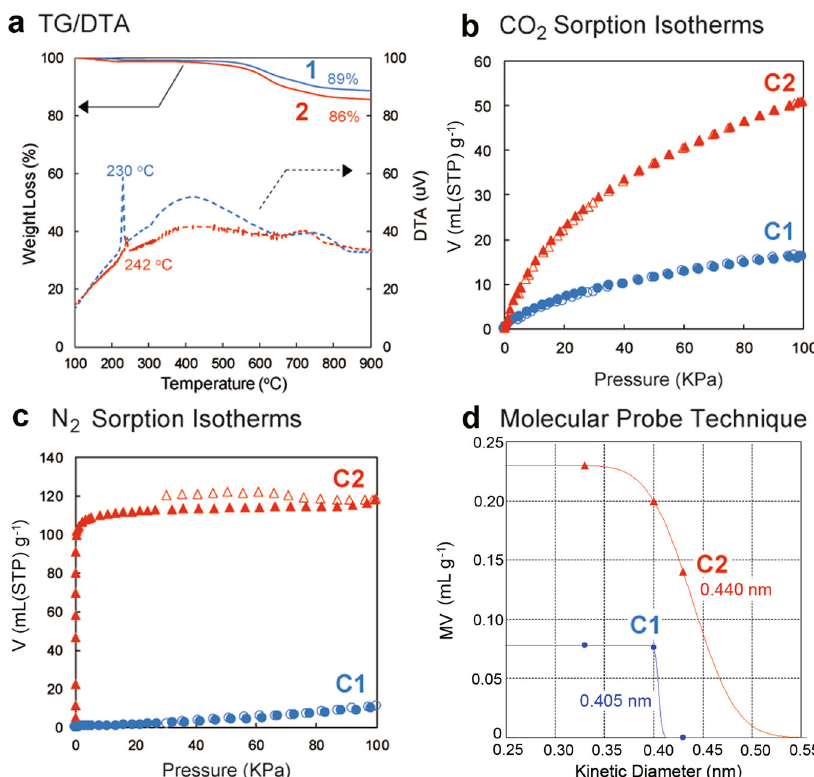
Fig. 2 Carbonization and determination of pore sizes by gas sorption measurements. a Thermo-gravimetric analysis (TGA, 1 : blue solid line, 2 : red solid line) and differential thermal analysis (DTA, 1 : blue dash line, 2 : red dash line) under a nitrogen atmosphere (heating rate: 1 °C / min). b CO 2 (25 °C) and c N 2 ( − 196 °C) sorption isotherms of the powders of porous carbons C1 (blue circles) and C2 (red triangles). Solid symbols = adsorption; open symbols = desorption. d Micropore volume (MV) of C1 (blue circles) and C2 (red triangles) estimated by the DA method, plotted against kinetic diameter of molecular